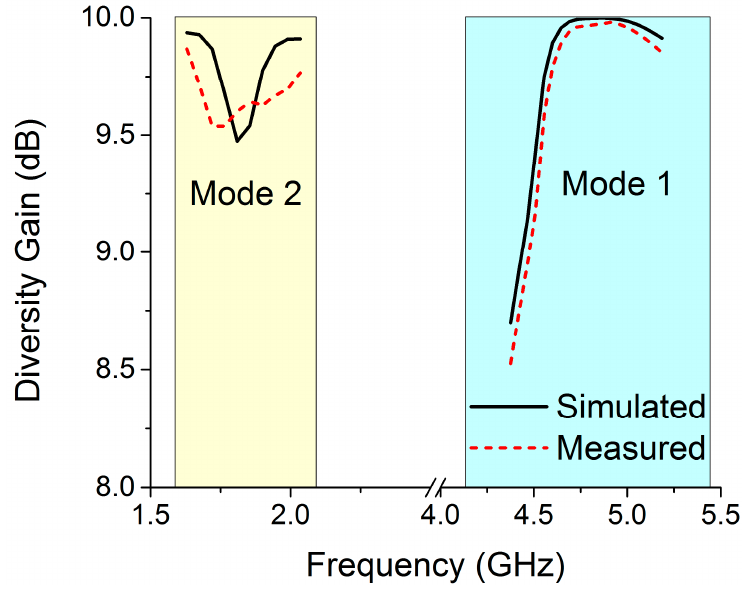
Figure 30. ECCs for the MIMO antenna in both modes.